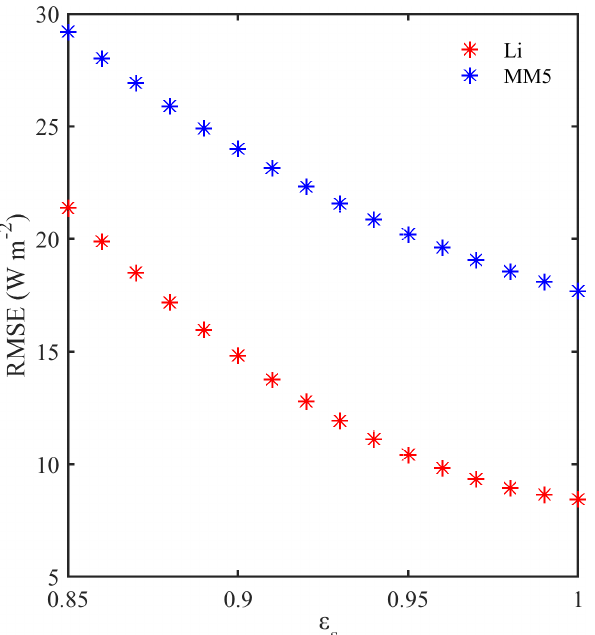
Figure 3. The surface emissivity ε s dependence of RMSE between observed near-neutral heat fluxes and parameterized heat fluxes (red for Li and blue for MM5) at Gucheng station.